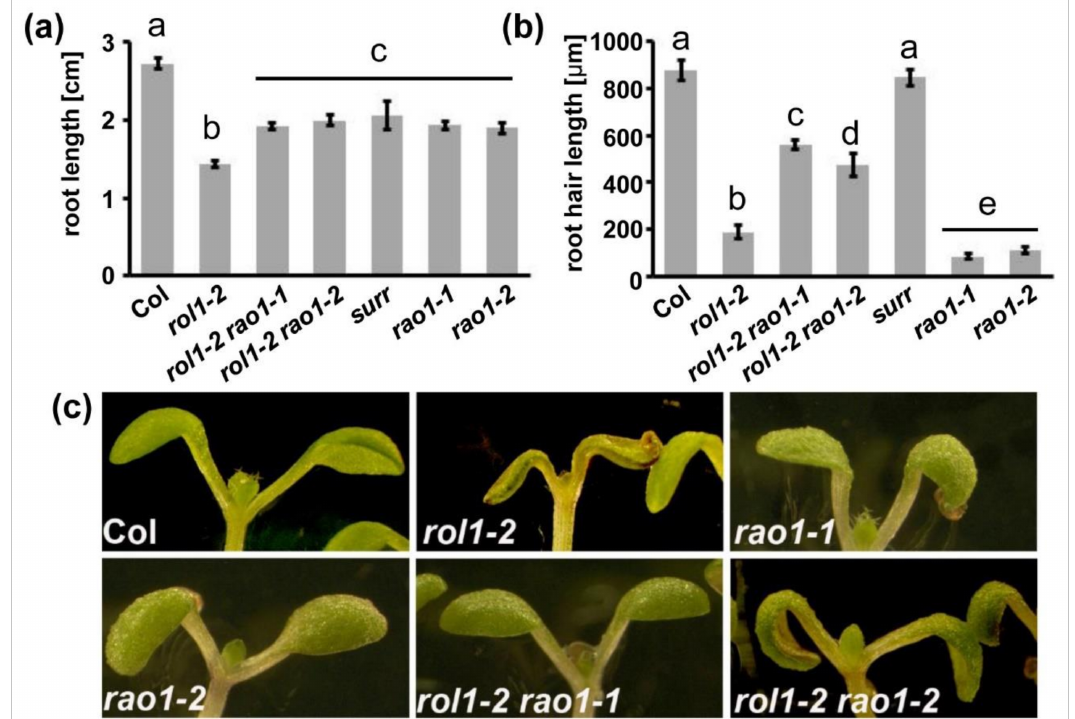
Figure 6. rao1 alleles suppress the rol1-2 growth defects. ( a ) Seedlings were grown for 5 days in a vertical orientation and root length was determined. Both rao1 alleles show shorter roots than the wild type and suppress the rol1-2 induced short-root phenotype. Significant differences are indicated by letters above the graph ( T -test, p < 0.01, n = 20). ( b ) In contrast to surr , the rao1 alleles develop significantly shorter root hairs. In combination with rol1-2 , however, both rao1 alleles induce longer root hairs than both rol1-2 and the rao1 single mutant. Significant differences are indicated by letters above the graph. ( T -test, p < 0.01, n = 50). Error bars represent standard deviations. ( c ) Cotyledon phenotype of the different lines. All except rol1-2 show epinastic cotyledons. Bar = 1